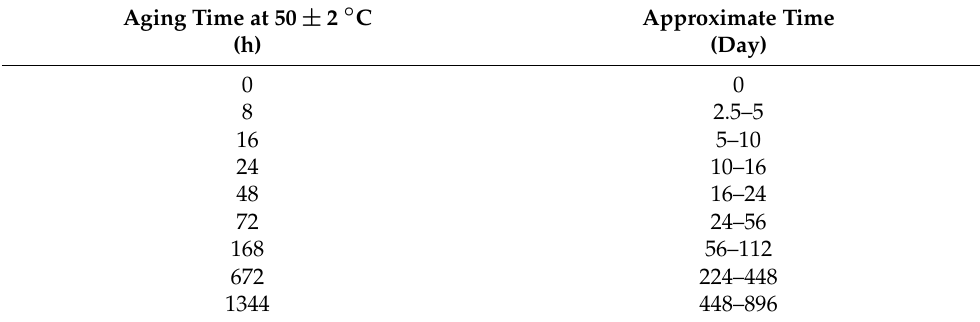
Table 1. Correlation between aging and service time as per the simplified protocol for accelerated